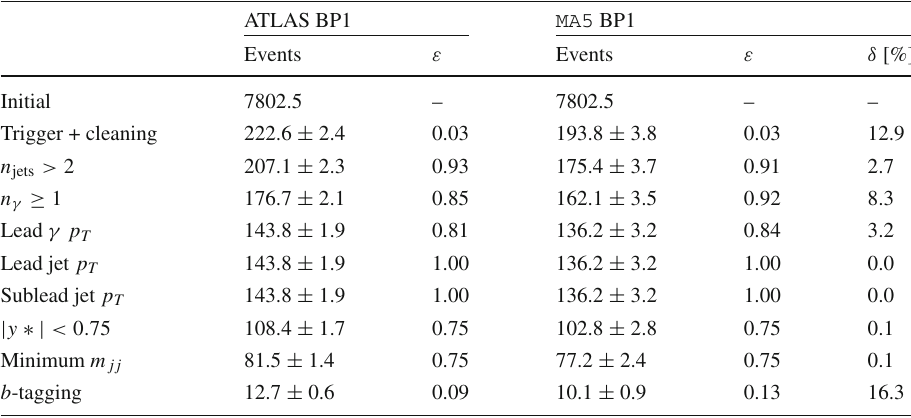
Table 5 Search for a di-jet resonance produced in association with a photon: cut flows for BP1 comparing the MA5 event analysis as